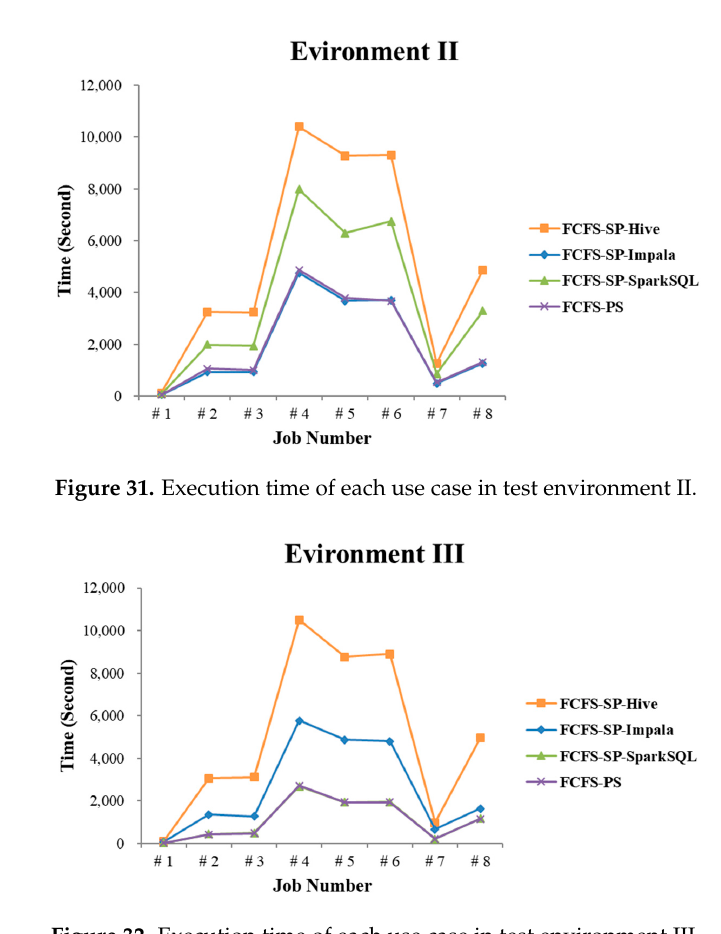
Figure 30. Execution time of each use case in test environment I.